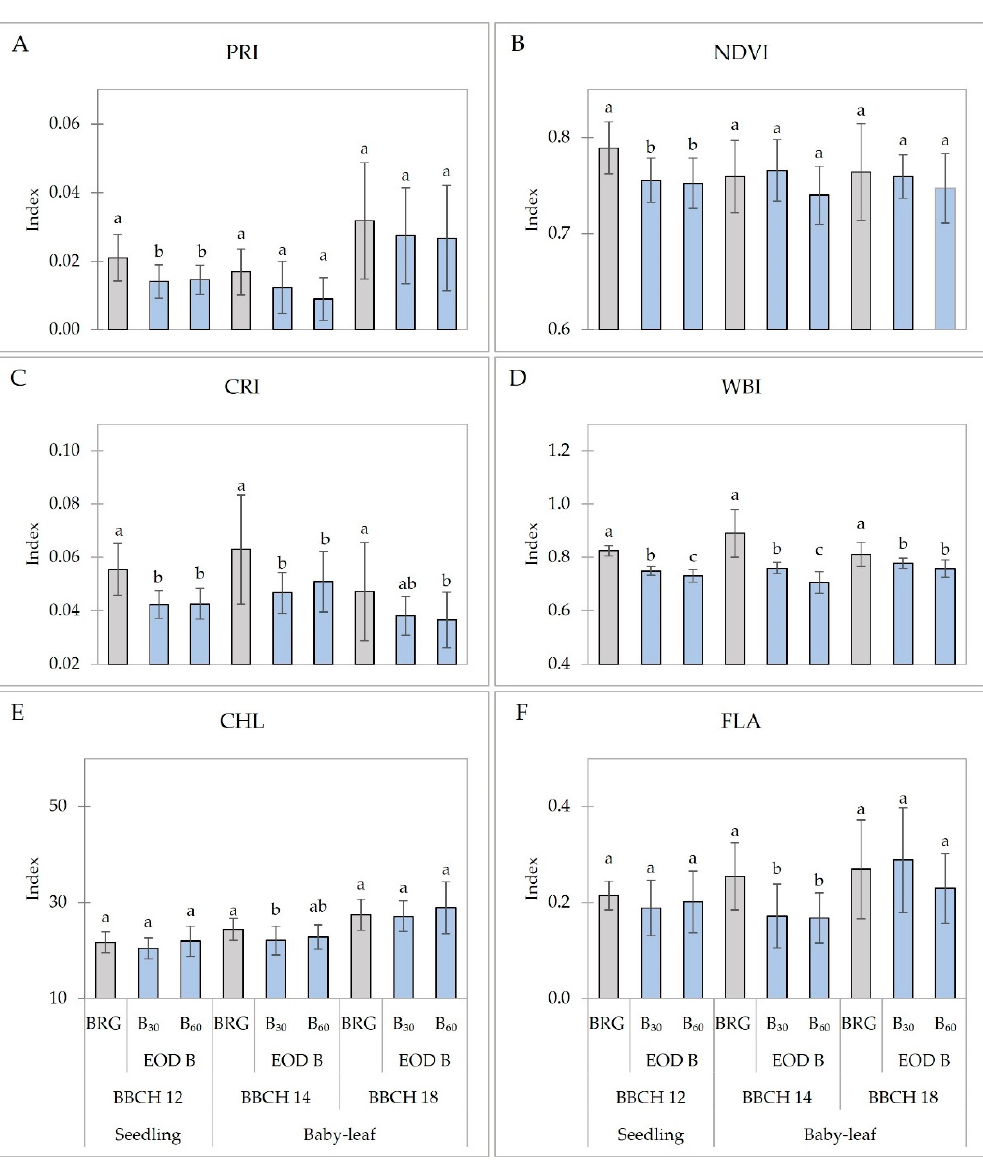
Figure 3. Spectral reflectance indices (( A ) photochemical reflectance index, PRI; ( B ) normalized difference vegetation index, NDVI; ( C ) carotenoid reflectance index, CRI; ( D ) water band index, WBI; ( E ) chlorophyll index, CHL; ( F ) flavonol index, FLA) of lettuce plants at different development stages. BRG, 5% blue (peak = 450 nm), 85% red (peak = 660 nm), 10% green (peak = 530 nm) for 16 h d − 1 (control; from 06:00 to 22:00); B 30 and B 60 , PPFD of end-of-day lighting with blue (peak = 450 nm) at 30 and 60 µ mol m − 2 s − 1 , respectively; EOD, end-of-day lighting for 4 h d − 1 (from 22:00 to 02:00). Data are means of two replications with ten samples per replication (n = 20). Means with different letters are significantly different from the control treatment (BRG) at p < 0.05. Indices on the ordinate axis are in relative